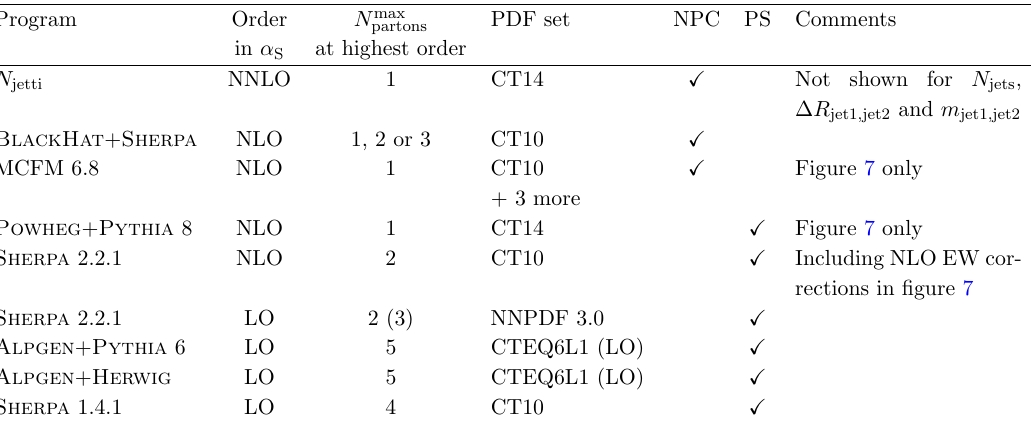
Table 5 . Summary of theoretical predictions, including the maximum number of partons at the highest order in (cid:11) S used in this analysis, the PDF set used, if non-perturbative corrections (NPC) are applied and if a modelling of the parton shower (PS) is included and additional comments. The maximum number of partons in between parentheses is only used in the estimate of systematic uncertainties in the NPC. NLO electroweak (EW) corrections are applied to the prediction at NLO in (cid:11) S